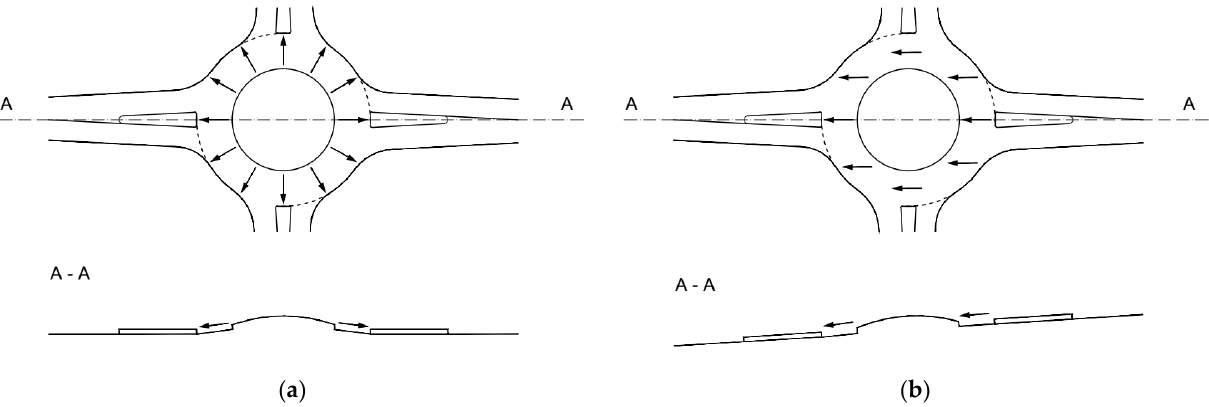
Figure 4. Circulatory roadway cross slope according to [5]: ( a ) recommended cross slope direction and ( b ) circulatory roadway in one plane. Slope direction is represented by the